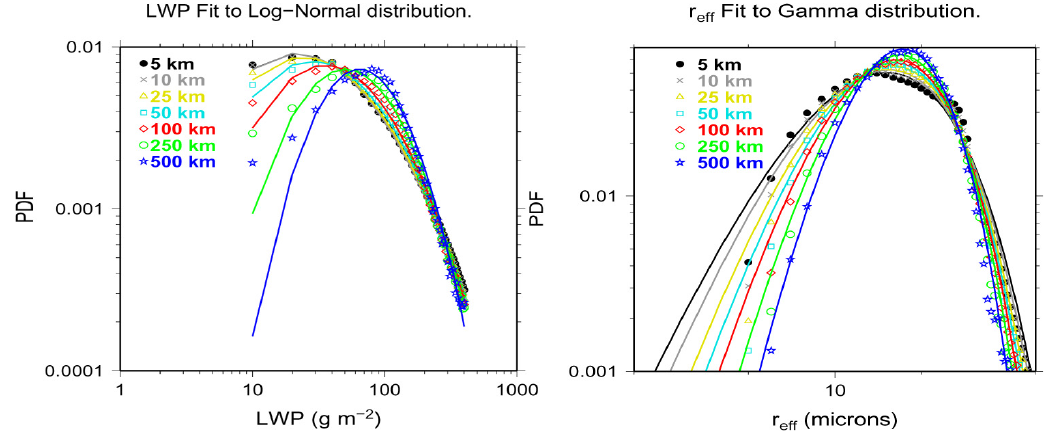
Fig. 6. PDFs for LWP and r eff in logarithmic scale highlight the increasing LWP anomaly at the low end of the log-normal